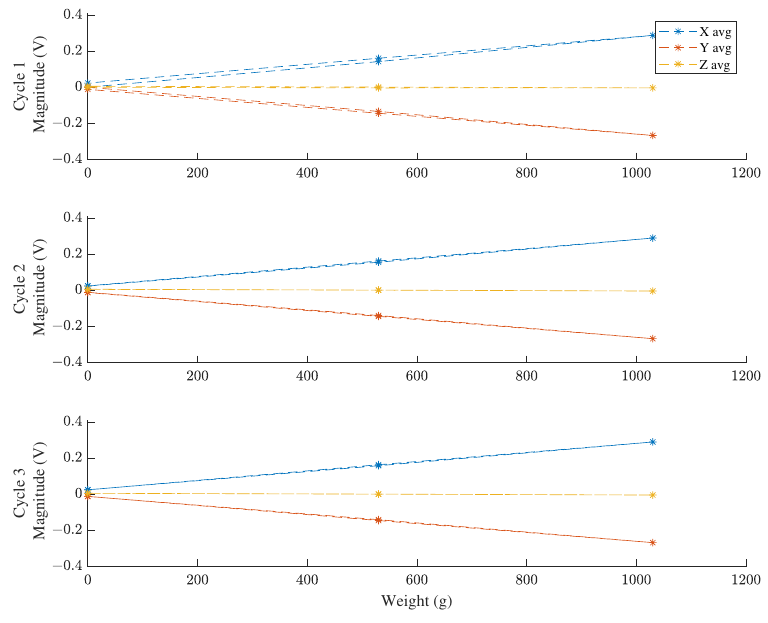
Figure 18. Voltage response to 3D calibration loading in 3 separate cycles in the +X − Y loading